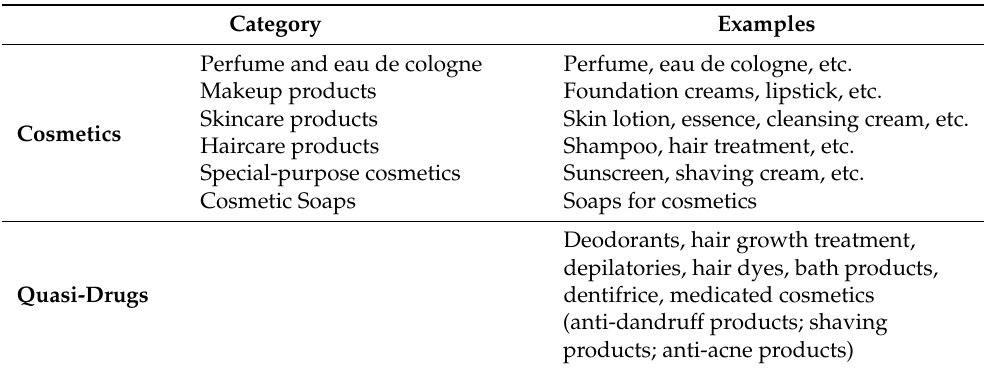
Table 2. Examples of cosmetic and quasi-drug products in